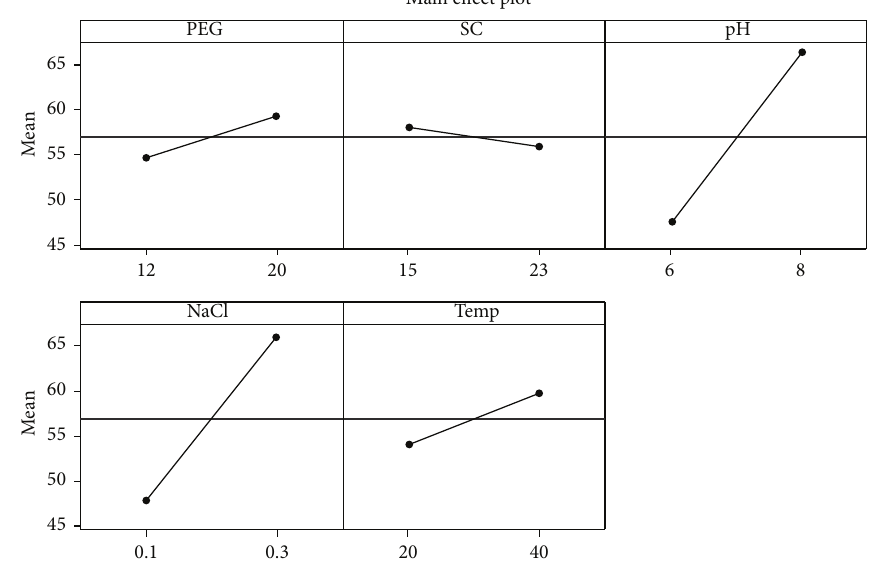
Figure 2: Main effect plot for recovery